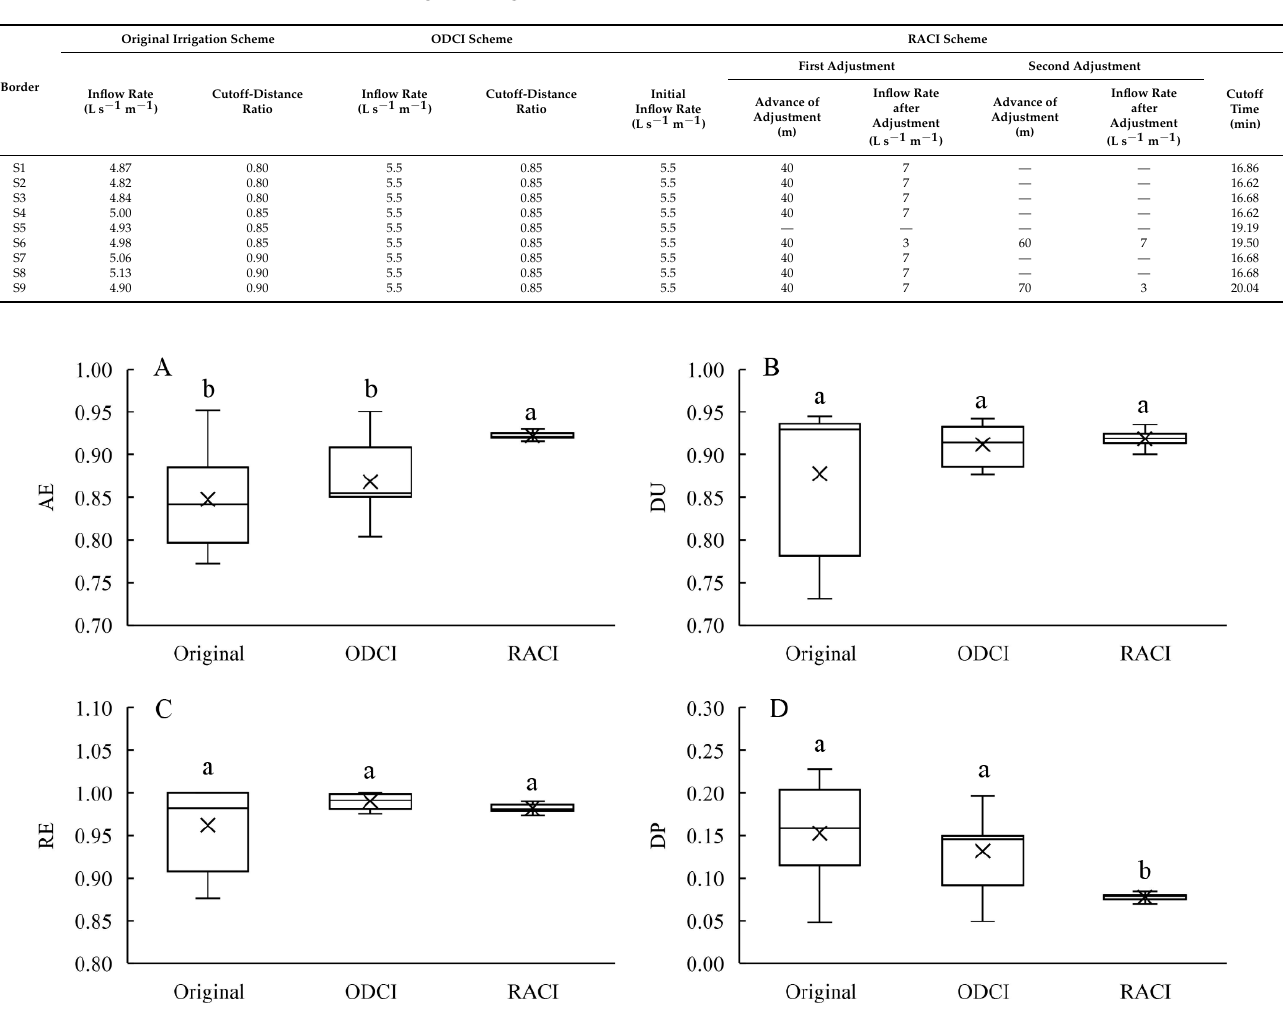
Table 3. Original irrigation, ODCI, and RACI schemes for borders S1–S9.